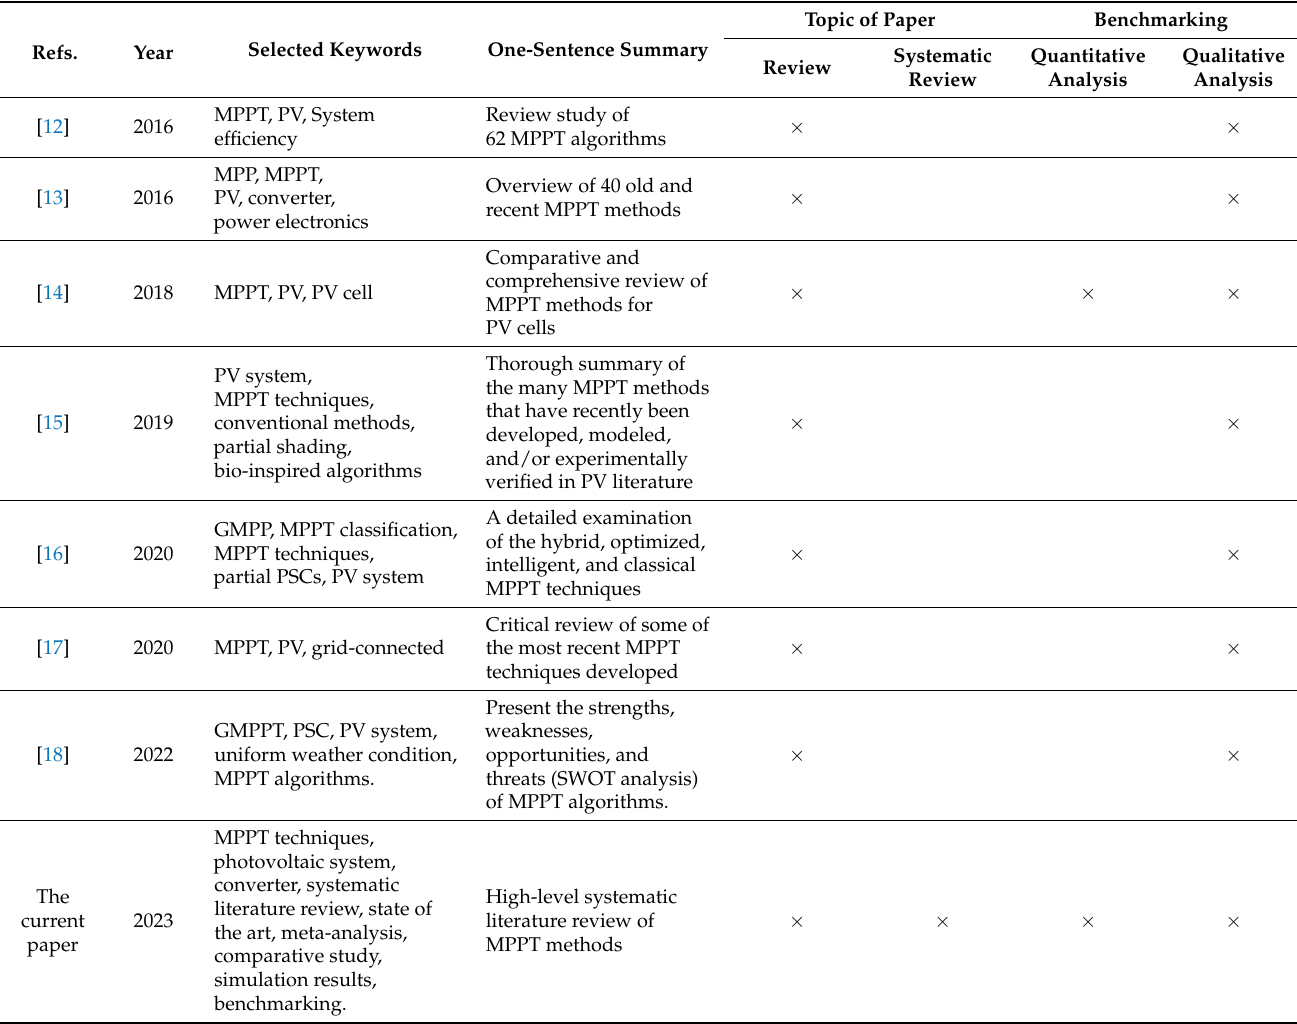
Table 1. Summary of the related reviews on MPPT from 2016 to 2022 and comparison of these reviews with the current review